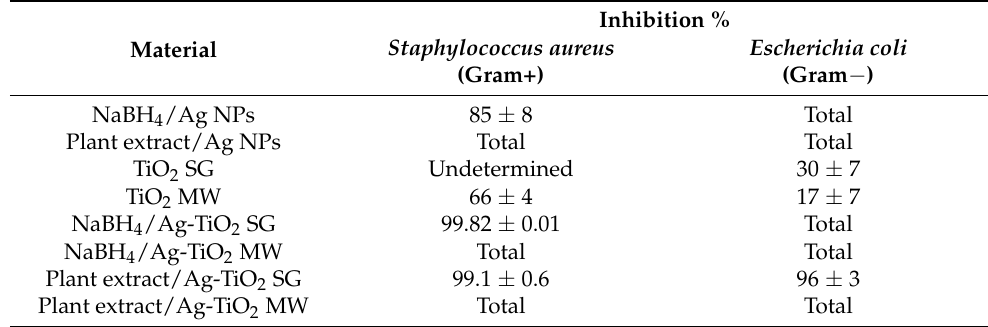
Table 5. Ag-TiO 2 bacterial inhibition growth